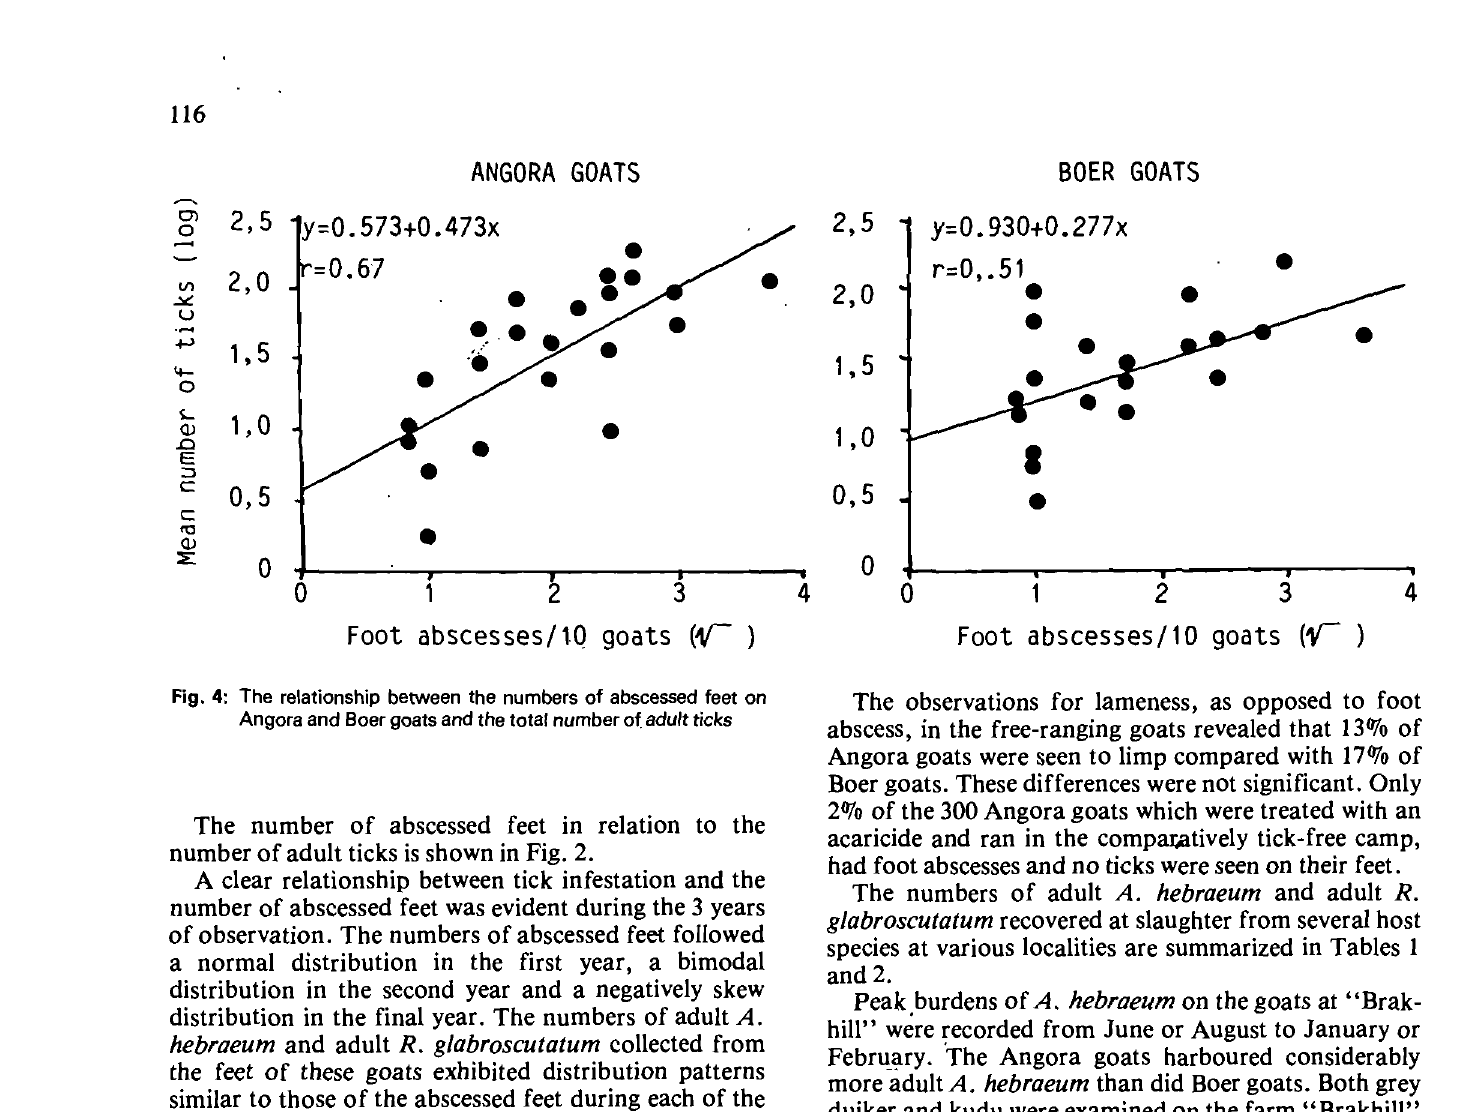
Fig. 4: The relationship between the numbers of abscessed feet on Angora and Boer goats and the total number of adult ticks